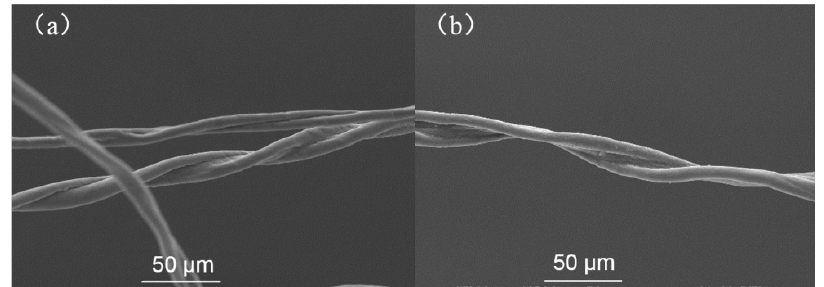
Figure 5. SEM images: ( a ) CF; ( b ) CF-TiO 2 .